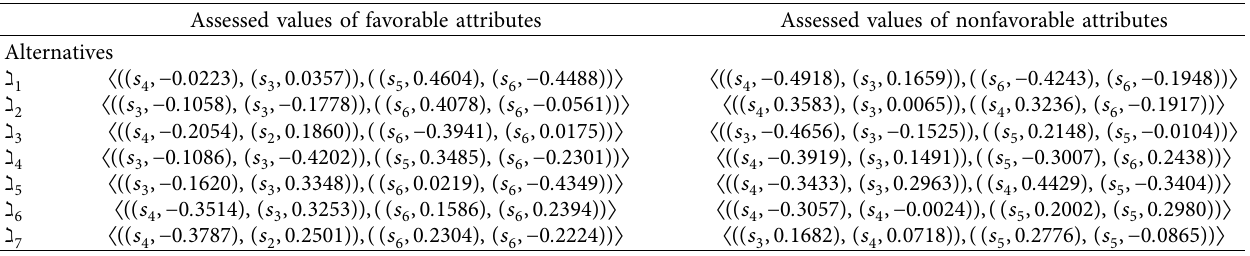
Table 6: Assessing values of favorable- and nonfavorable-type attributes by the 2TLC q -ROFHWA operator. Assessed values of favorable attributes Assessed values of nonfavorable attributes